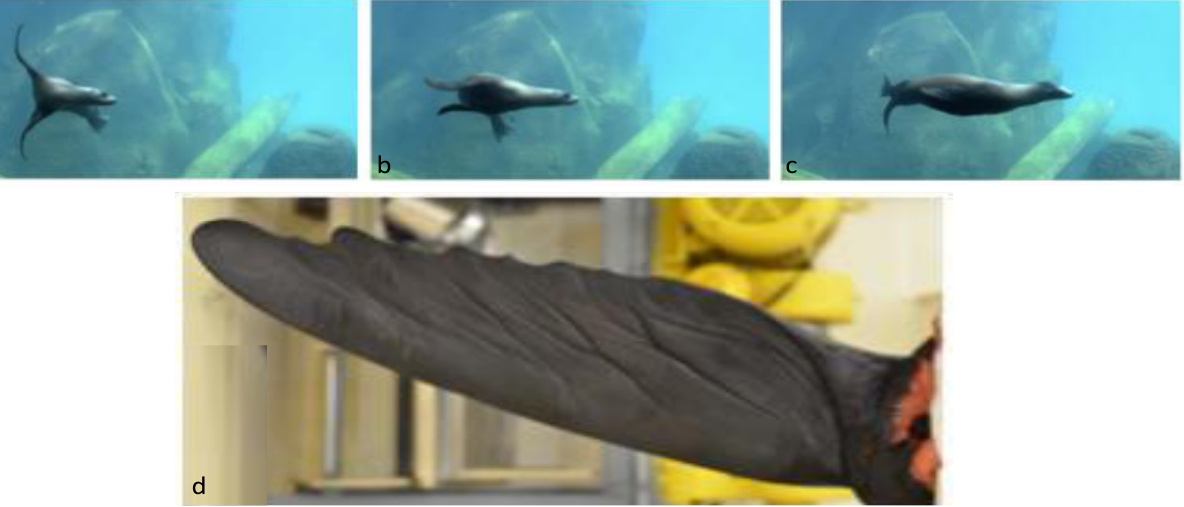
Figure 1. The top row ( a – c ) show the cycle of the sea lion’s propulsive stroke. Thrust is produced by the large foreflippers. The bottom panel ( d ) is an image of a foreflipper of an adult female California sea lion. The image shows the underside of the flipper; the side that would touch the body in panel ( c ).